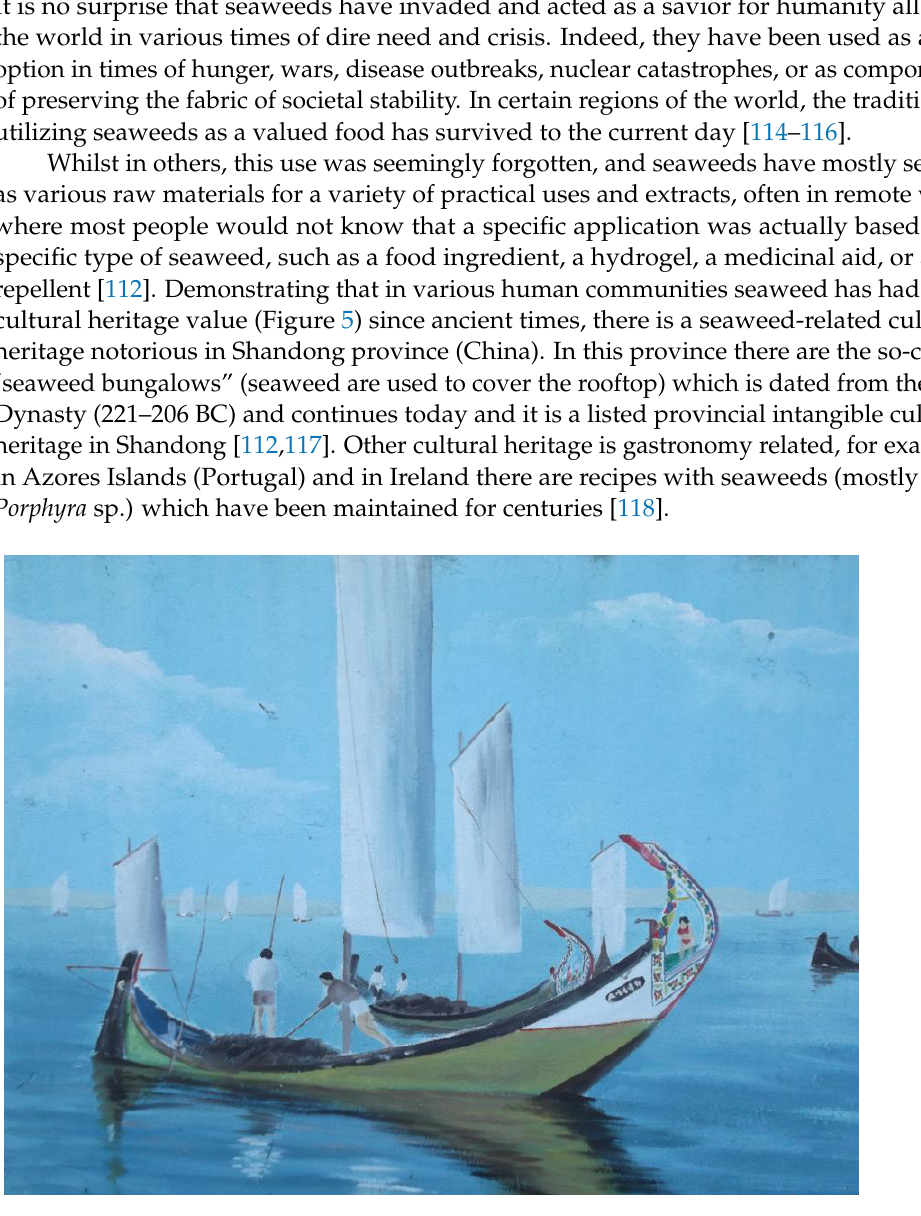
Figure 5. House painting representing the “moliço” harvesting at Ria de Aveiro (Murtosa, Aveiro, Portugal), which “moliço” consist in the harvest of seaweeds and aquatic plants to fertilize the agricultural soil, seaweed tradition, and regional cultural heritage.